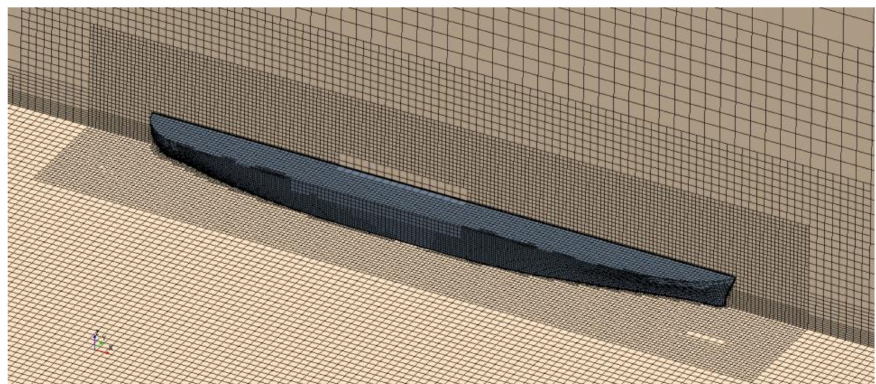
Figure 7. Refined grid near the free surface and hull.